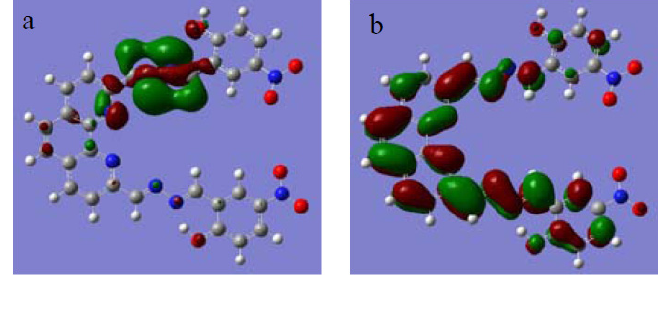
Figure 6. Molecular orbital levels of compound 1 : ( a ) HOMO; ( b )